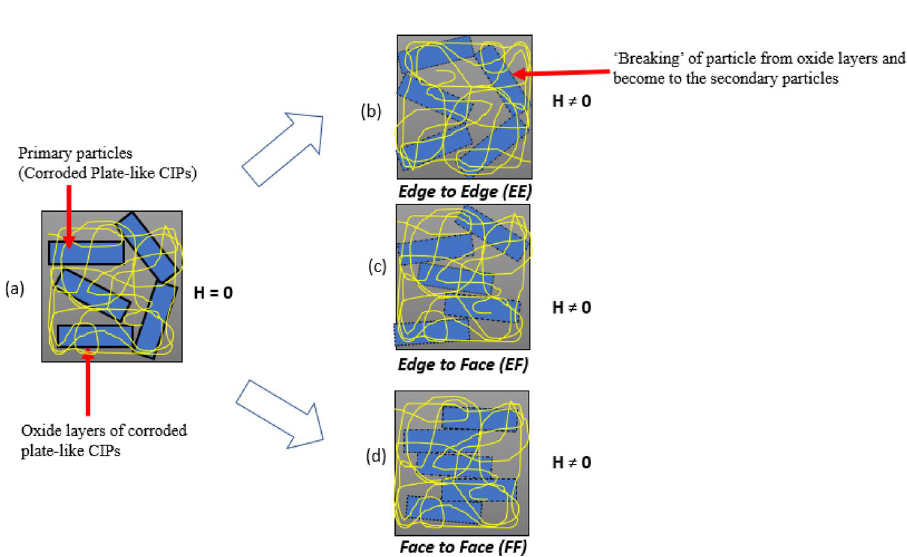
Figure 12. Schematic of the possible mechanisms of stacking interaction corroded plate-like CIPs in MRE-P under the applied magnetic